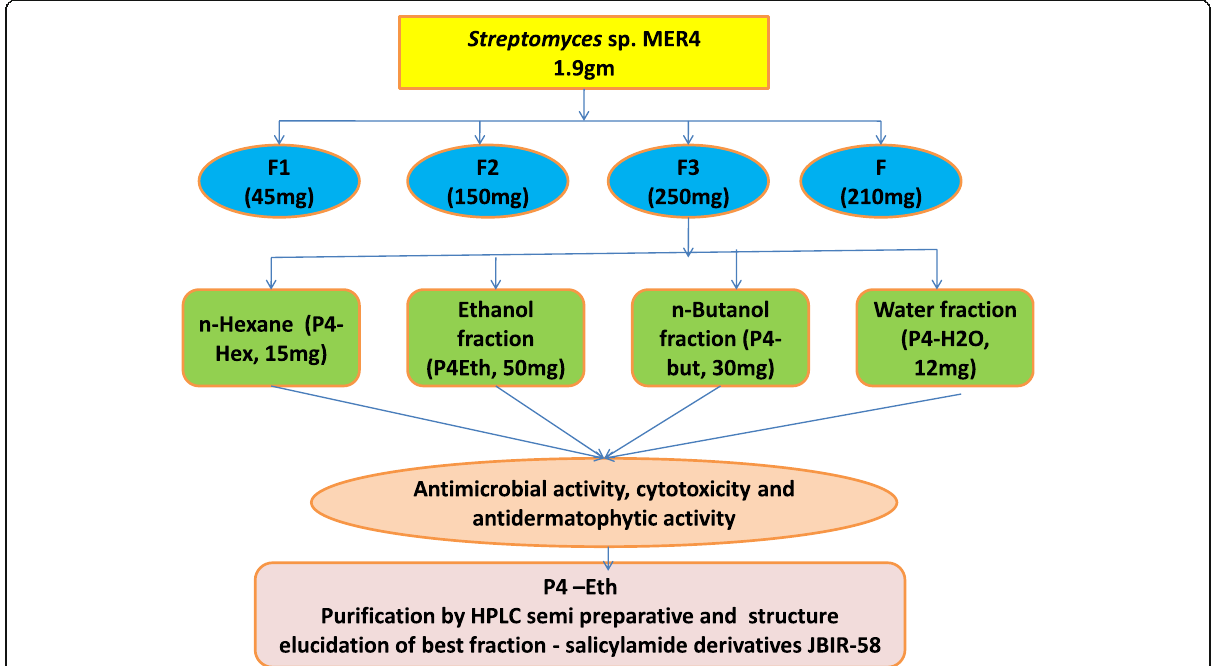
Fig. 2 Fractionation and purification scheme of Streptomyces sp. MER4 ethyl acetate extract